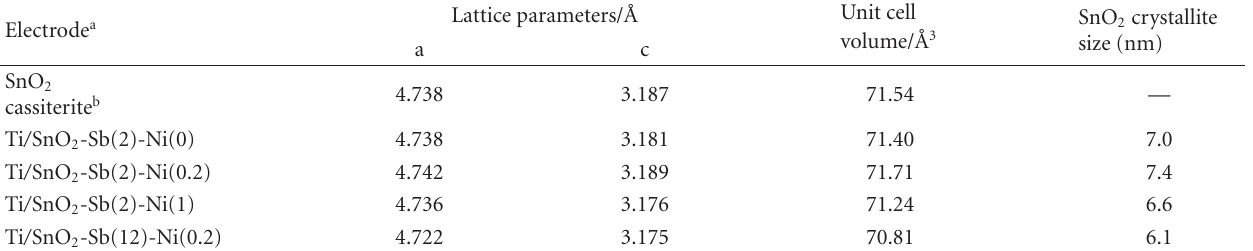
Table 2: Lattice parameters (a = b, and c), unit cell volume (V), and crystallite size of four di ff erent Ni-and Sb-doped SnO 2 films coated on Ti substrate.